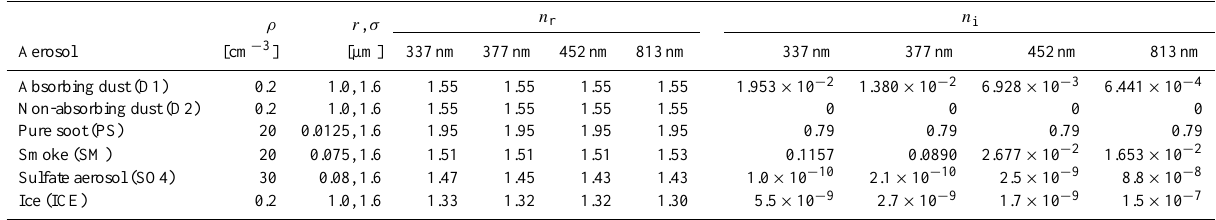
Table 2. Physical (number concentration ρ , lognormal mode radius, r , lognormal mode width, σ) and optical (complex index of refraction n r , n i ) properties of aerosol layers simulated either alone (between 10–15km) or in conjunction with air molecules (between 0–100km).